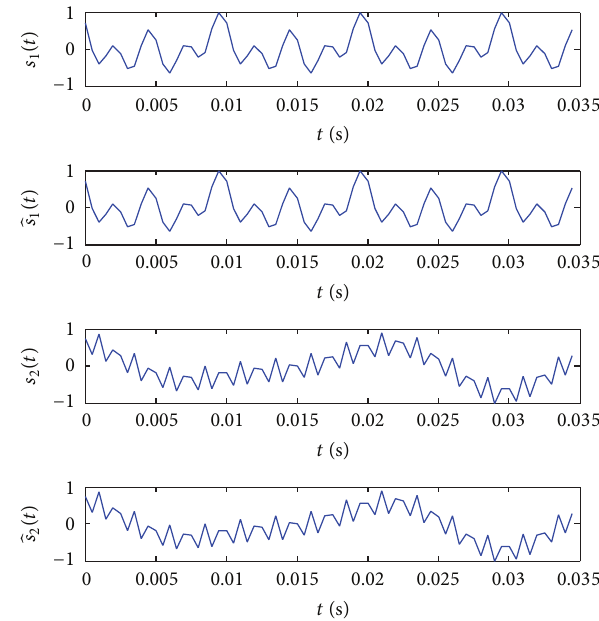
Figure 2: Numerical results of proposed BSS algorithm ( 𝐿 = 400 ).